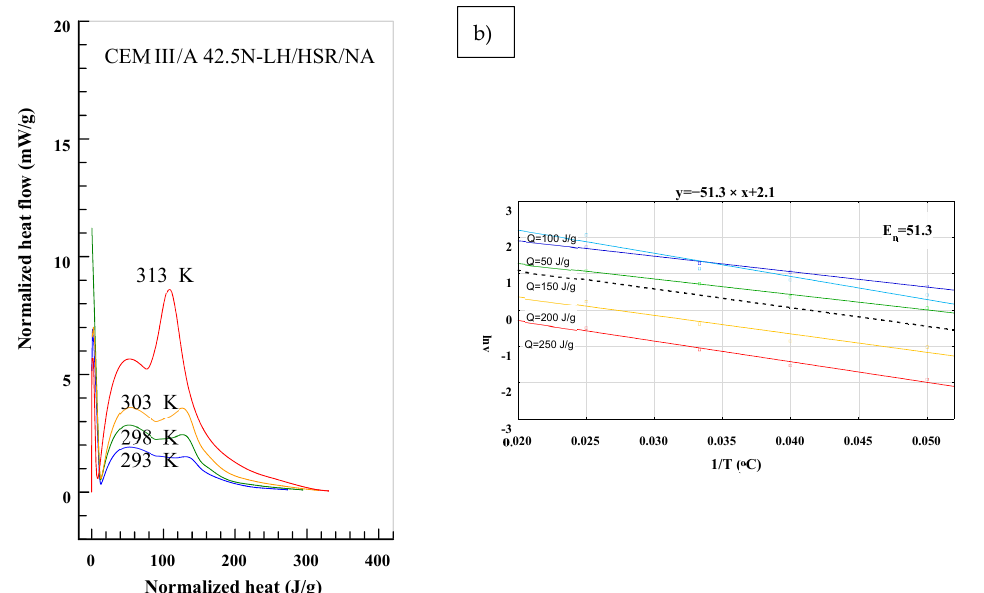
Figure 4. Determination of the En from the Equation (2) for CEM I 42.5 R. ( a ) Normalized heat flow in comparison to total heat gen- erated for different temperatures, ( b ) Values of En for different temperatures and it’s representative value calculated using least- square method.